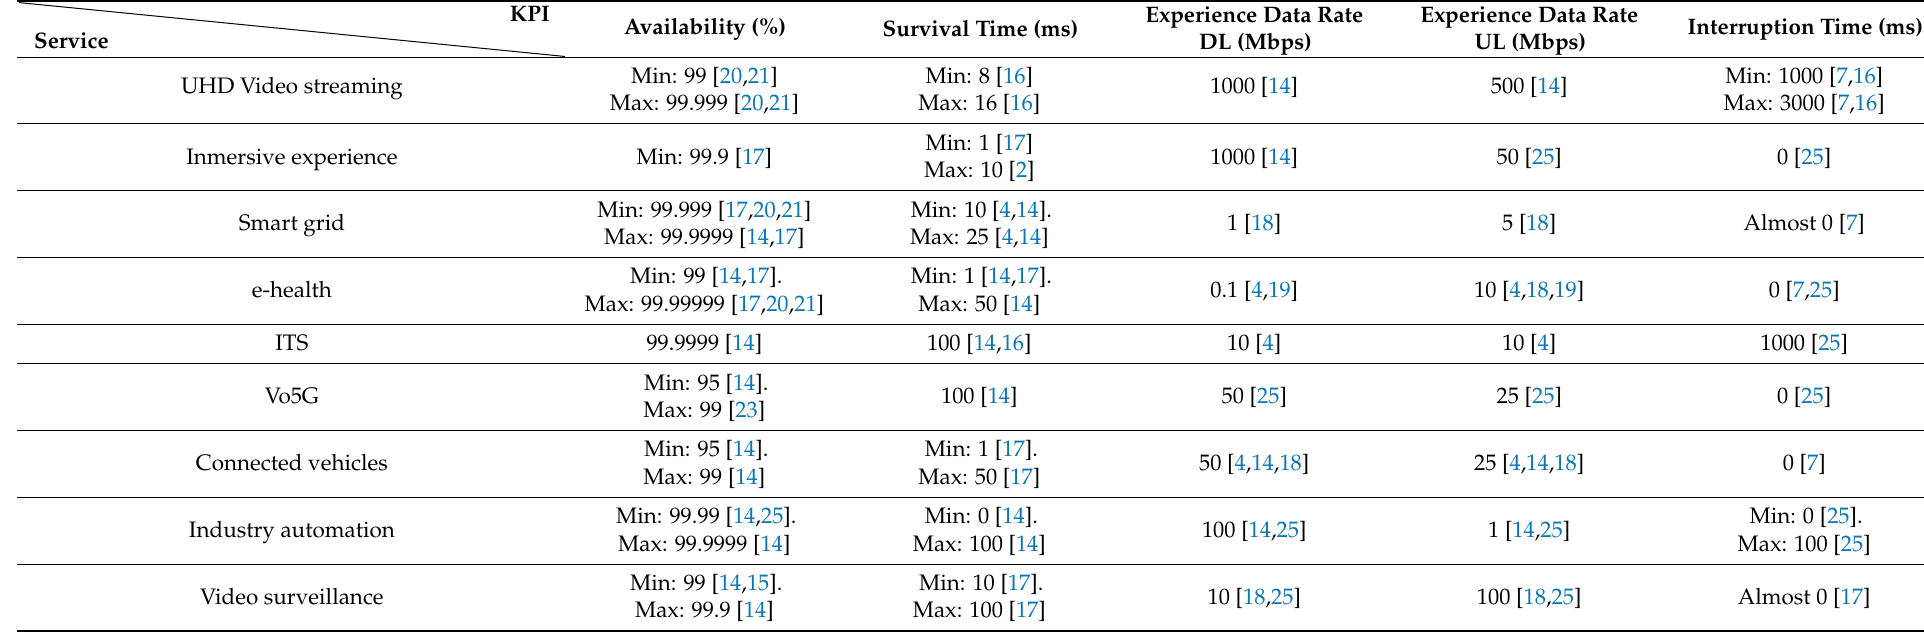
Table A2. 5G service KQI